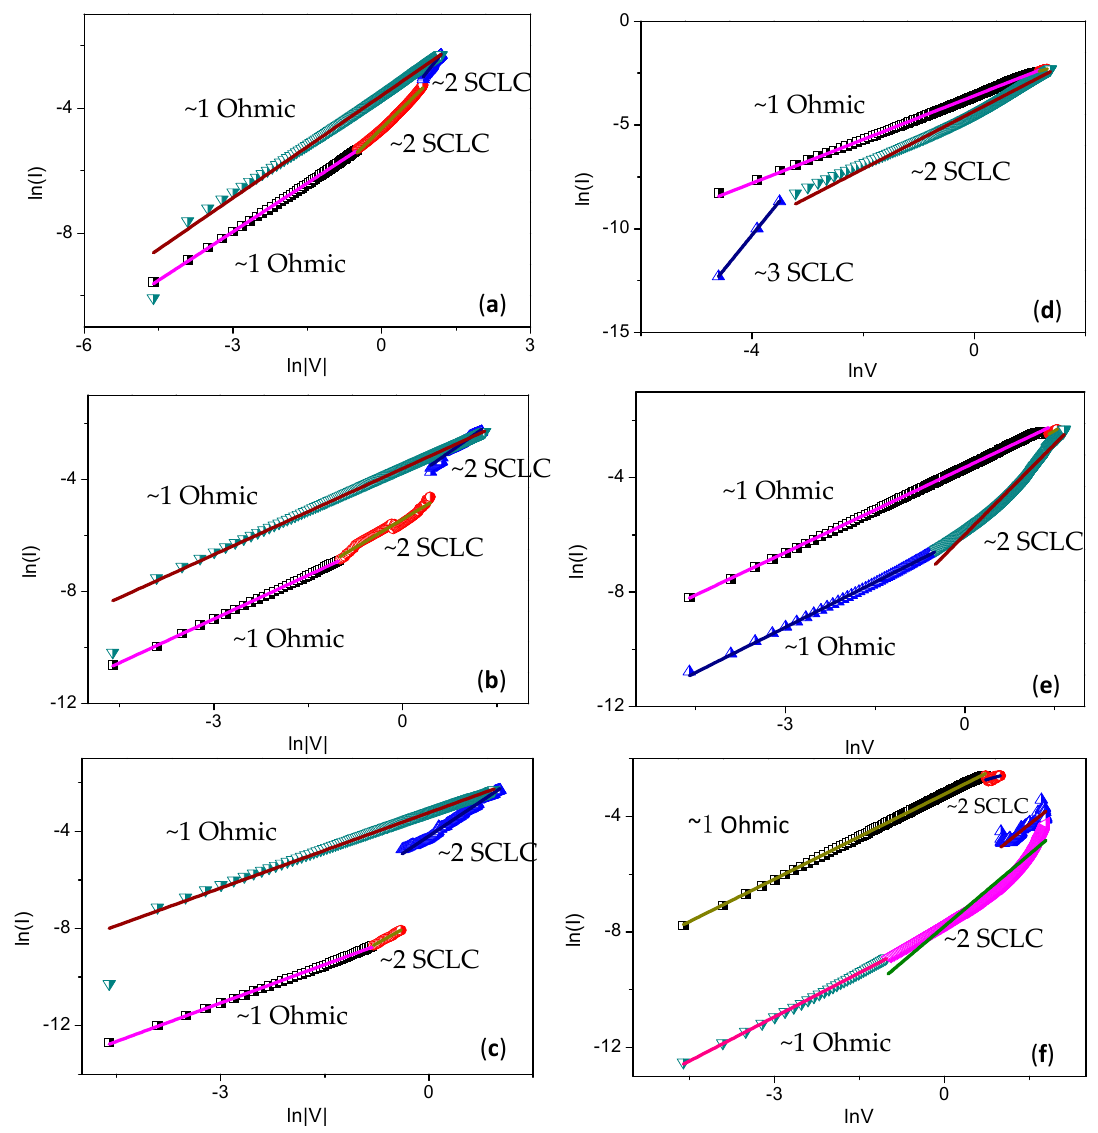
Figure 12. Measured and fitted I - V curves of the resistive switching memory devices based on PBD:GO blends. Measured and fitted semilogarithmic I - V curves for the component ratio of PBD:GO ( a ) 2:1, ( b ) 5:1, and ( c ) 10:1 (w/w) in negative sweeps; Plots of log I -log V with fitted conduction mechanism in positive sweeps for the component ratio of PBD:GO ( d ) 2:1, ( e ) 5:1, and ( f ) 10:1 (w/w).